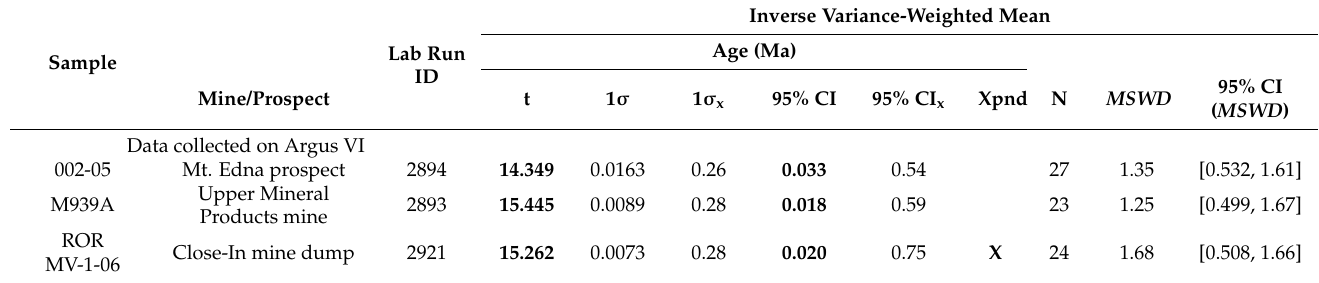
Table 2. Summary of inverse variance-weighted mean 40 Ar/ 39 Ar dates for samples of magmatic- steam alunite from Alunite Ridge, Marysvale, Utah. Preferred ages are in bold. Age uncertainties are provided at both the 1 σ and 95% confidence (95% CI) levels, and include the error in J; external uncertainties (denoted by a subscript x) also include decay constant uncertainties. Dates have been rounded to the same decimal place as the 95% CI (internal) uncertainties, which are rounded to 2 significant figures. Acceptable MSWD values fall within the 95% confidence intervals computed following the methods of Mahon, 1996 [40]. Where the MSWD values are unacceptable, the 95% CIs √ MSWD and are denoted with an X in (internal and external) of the ages have been expanded by the Xpnd column; the 1 σ uncertainties are provided without